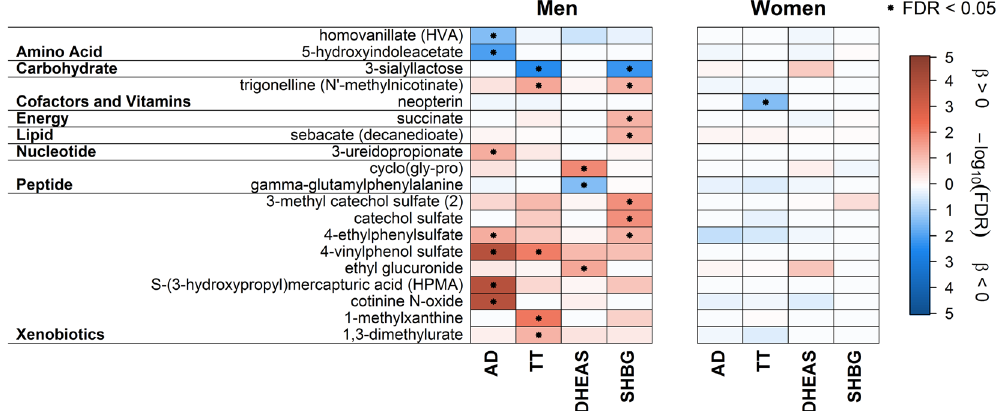
Figure 3. Heatmap of urine metabolites, excluding steroids and unknown compounds, significantly associated in linear regression analyses with either androstenedione (AD), testosterone (TT), dehydroepiandrosterone sulfate (DHEAS) or sex hormone-binding globulin (SHBG) in men ( left panel ) and women ( right panel ), respectively. Orange shading denotes positive and blue shading inverse associations. Dots indicate significant associations by controlling the false discovery rate (FDR) at 5%. Metabolites were grouped according to physiological entities as denoted on the left. Corresponding estimates and FDR values from linear regression analyses can be found in Tables S3 and S4. * Metabolites were annotated based on fragmentation